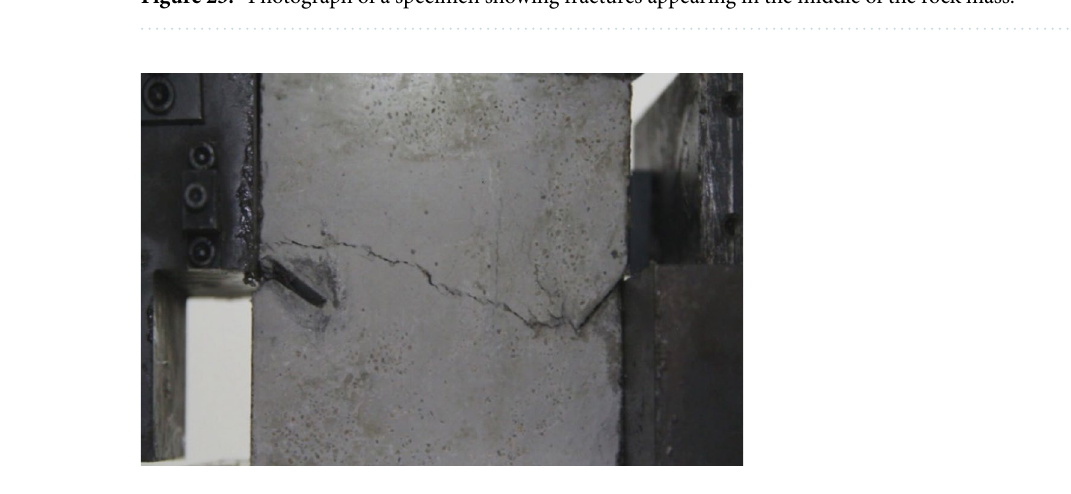
Figure 24. Photograph of a specimen showing fractures propagation.